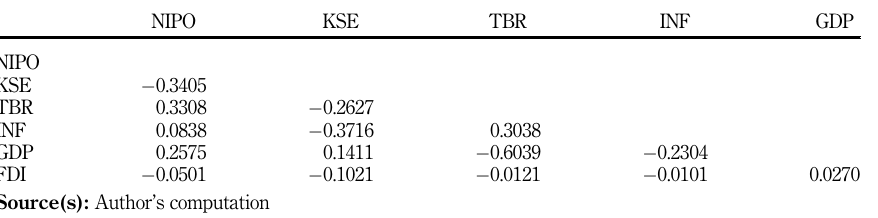
Table 2. Correlation matrix